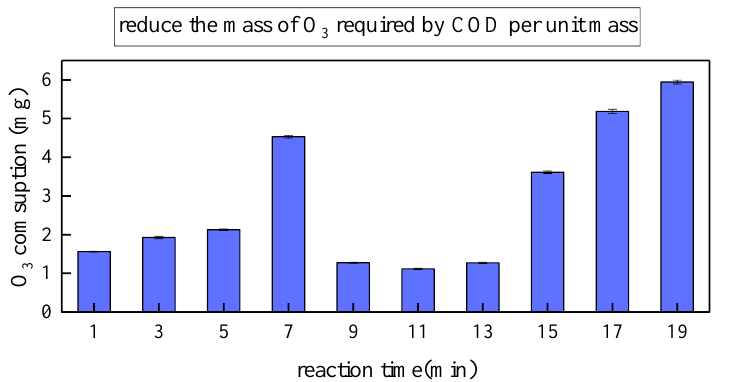
Figure 5. Ozone consumption curve and COD degradation under the combined action of ozone (25 g·m − 3 ) and manganese dioxide as catalysts (6 g·L −1 ).